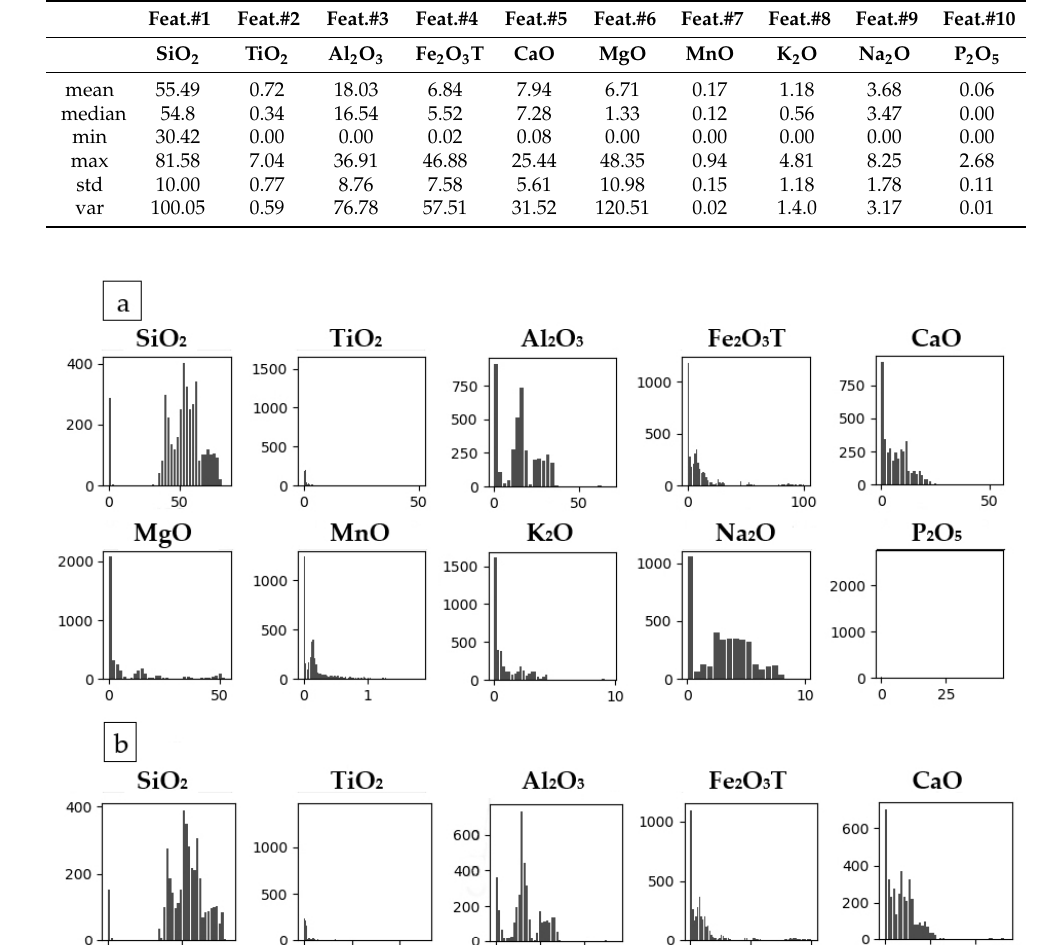
Table 8. Basic statistics of Dataset 6.